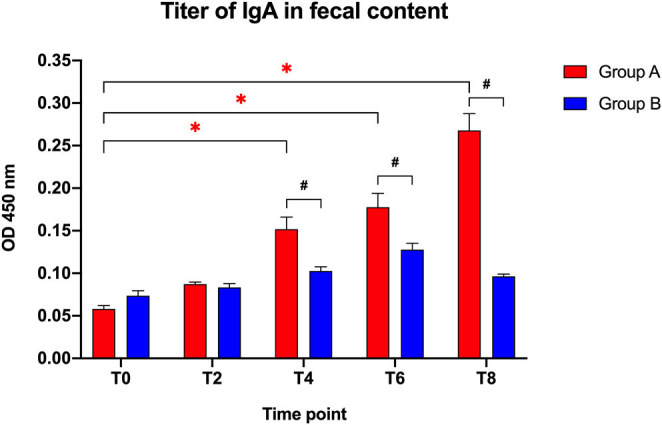
Immunoglobulin IgA titers in fecal contents collected at the beginning of the study (T0), after 2 weeks (T2), 4 weeks (T4), 6 weeks (T6), and 8 weeks (T8) in dogs fed the same diet with (Group A) or without Slab51® probiotic supplement (Group B). Black hashtags indicate statistical significance between groups. Red asterisks indicate statistical significance by study times within group A.